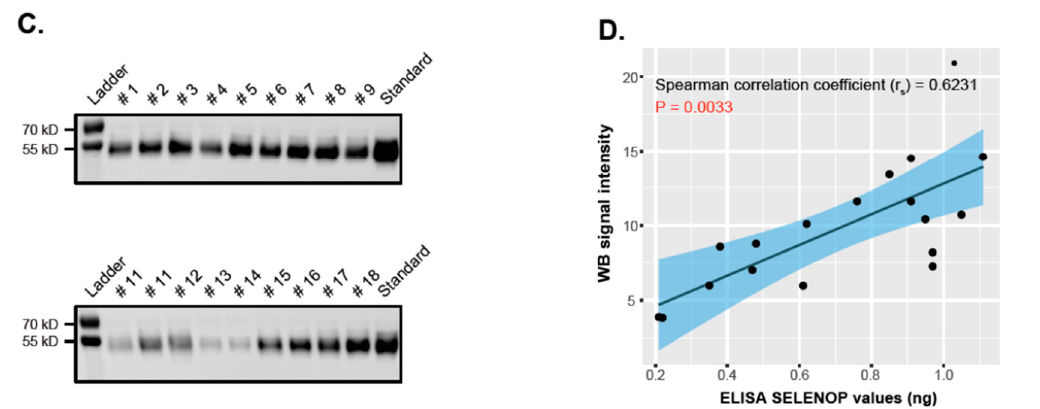
Figure 4. Validation of ELISA results by Western blot (WB) analyses using two independent antibodies. Plasma samples from the NIST1540 reference sample were used for optimizing and standardizing SELENOP quantification by Western blot with ( A ) an in-house and ( B ) a commercial antibody. ( C ) Western blot-based analysis detected the typical SELENOP band pattern. ( D ) Western blot results correlated over the full concentration range with the SELENOP values determined by ELISA.